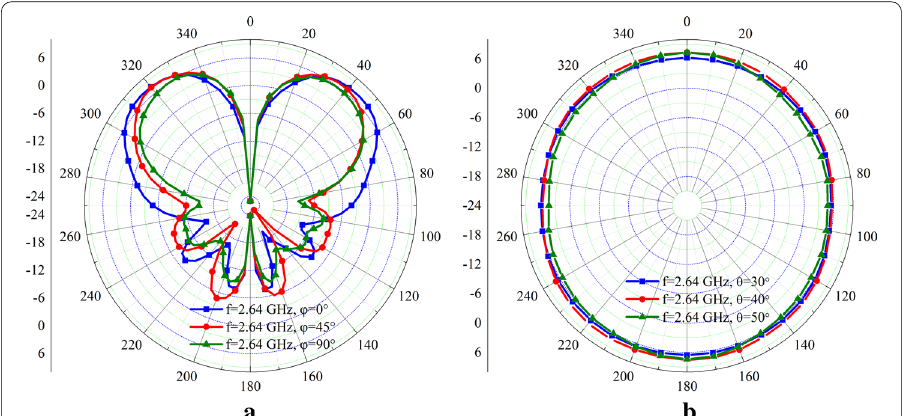
Fig. 8 The radiation pattern of antenna at 2.64 GHz. a Vertical radiation pattern. b Horizontal radiation pattern